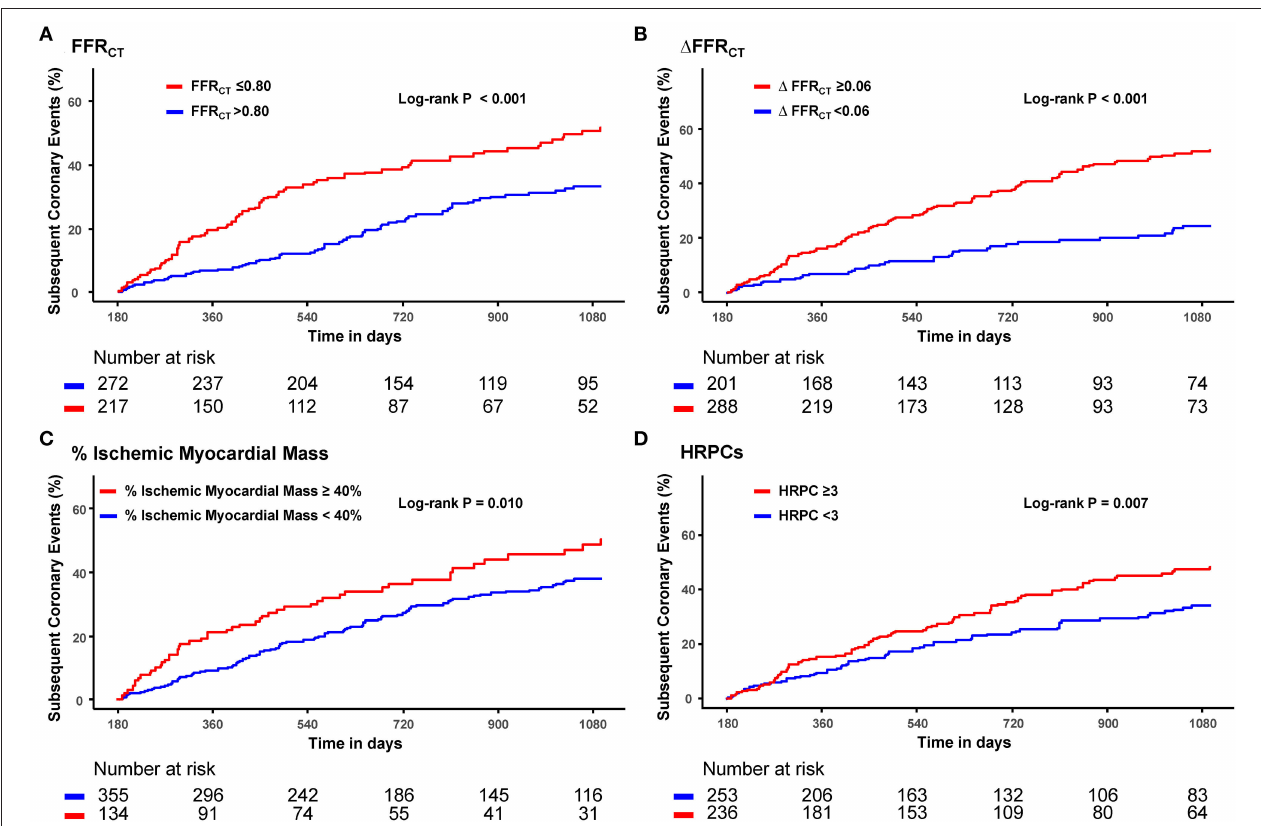
FIGURE 3 | Cumulative incidence of subsequent coronary events according to FFR CT , 1 FFR CT , % ischemic myocardial mass, and HRPCs. Cumulative incidence of subsequent coronary events according to optimal cutoff values of (A) FFR CT , (B) 1 FFR CT , (C) % ischemic myocardial mass, and (D) HRPCs. FFR CT , fractional flow reserve by coronary computed tomography angiography; HRPCs, high-risk plaque characteristics.